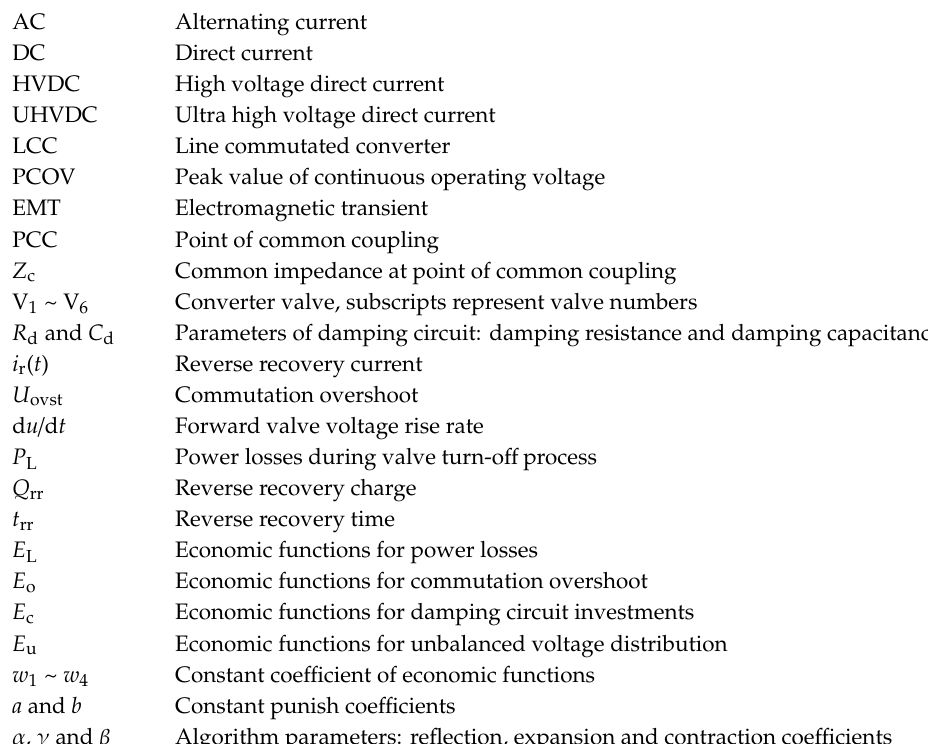
Algorithm parameters: reflection, expansion and contraction coe ffi